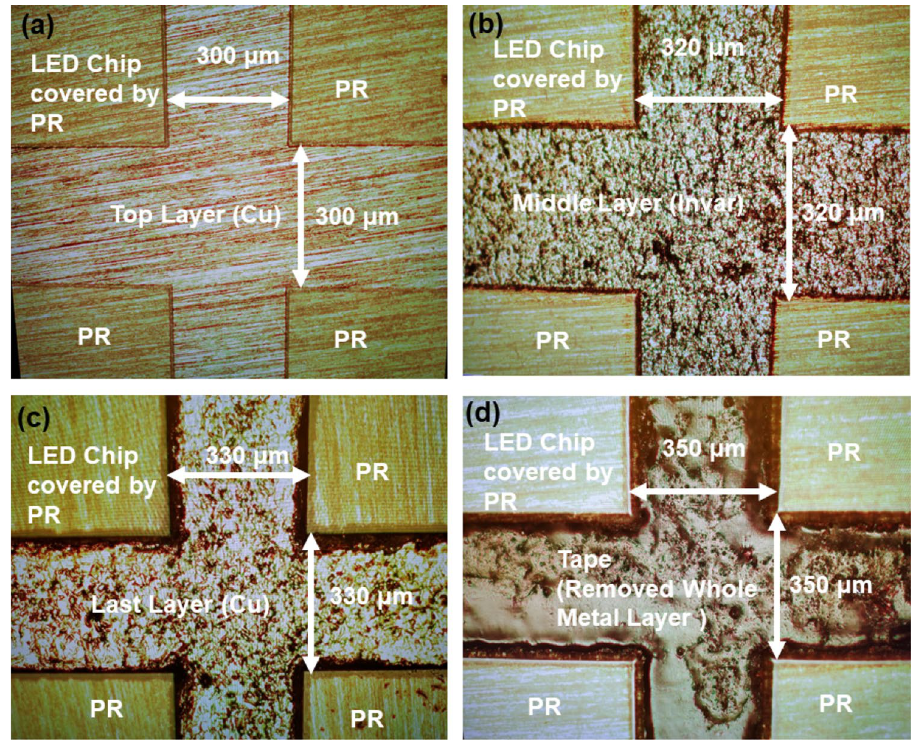
Figure 1. Channel variations of the chip pattern during the dicing process as measured by optical microscope (OM): ( a ) top layer (Cu); ( b ) middle layer (Invar); ( c ) bottom layer (Cu); ( d ) removed whole